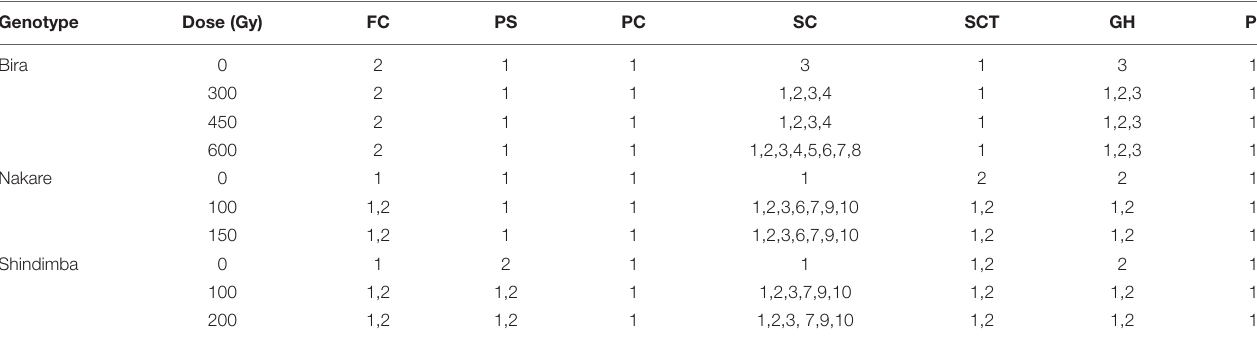
FC, flower color, where 1 = white, 2 = purple; PS, pod shape, where 1 = straight, 2 = coiled or curved; PC, pod color, where 1 = cream; SC = seed color, where 1 = white, 2 = brown, 3 = red, 4 = cream, 5 = speckled, 6 = chocolate, 7 = light brown, 8 = black, 9 = mixed, 10 = dark brown; SCT, seed coat texture, where 1 = smooth and 2 = rough; GH, growth habit, where 1 = bushy, 2 = erect and 3 = spreading; PI, pest infestation, where 0 = none, 1 = mild, and 2 = severe.